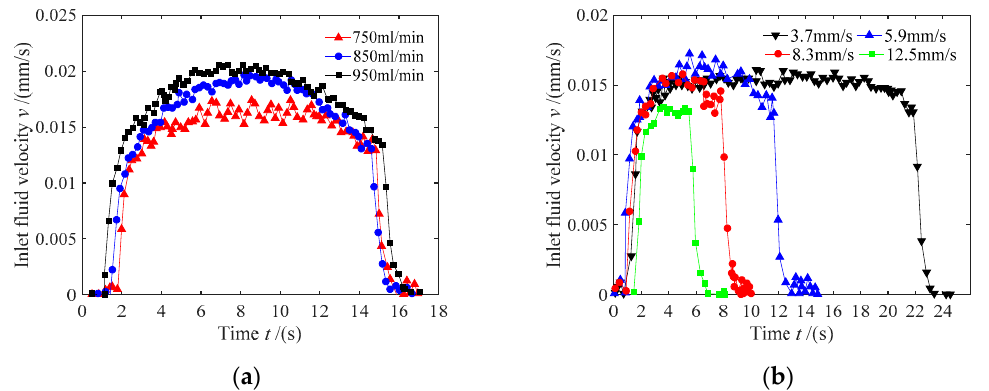
Figure 5. Inlet fluid velocity of piston chamber with different boundary conditions. ( a ) Inlet fluid velocity with different pump inlet flows; ( b ) Inlet fluid velocity with different piston moving speeds.